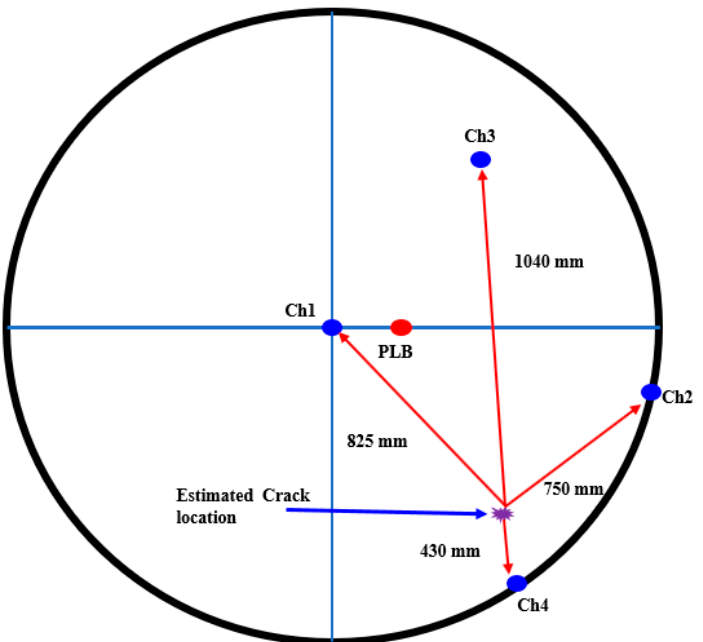
Figure 16. Crack position estimation through the velocity and time of arrival technique.